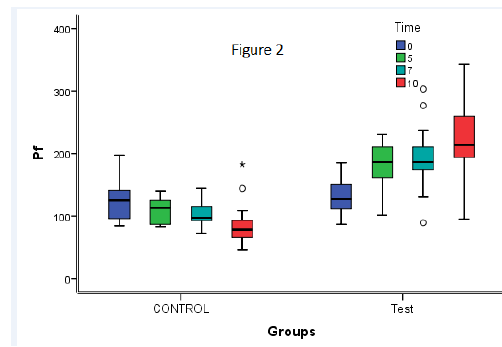
Fig. 2. P/F ratio between the control and the test